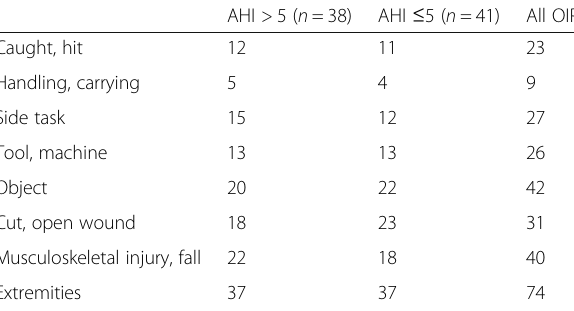
Table 3 Distribution of different work injury types according to apnea – hypopnea index (AHI) in the OIP group ( n =